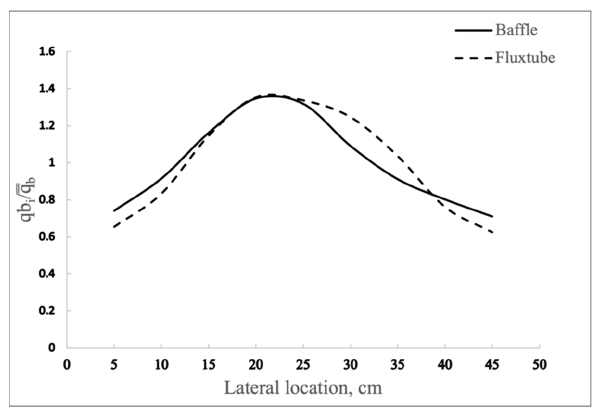
Figure 8. Radial gas bubble distribution profiles at injection level using the symmetrical baffle with and without the fluxtube under the superficial gas velocity of 0.4 m/s for the even gas inlet configuration.